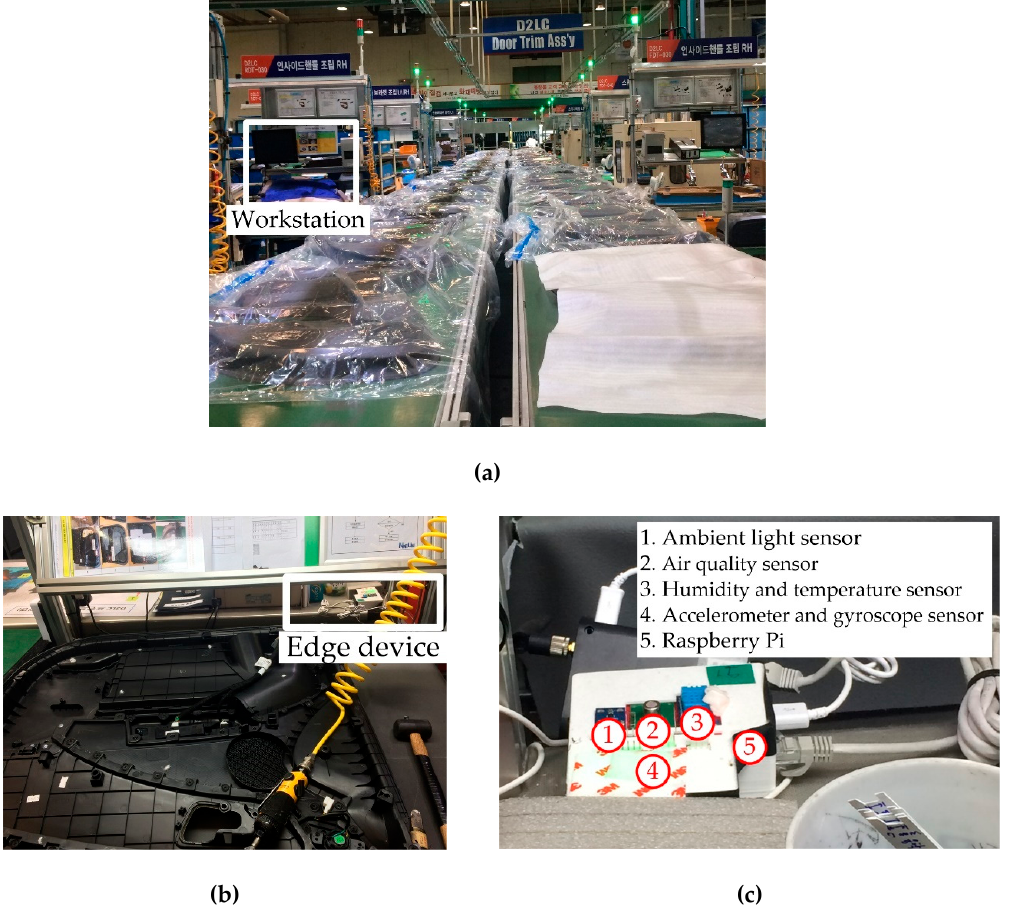
Figure 3. Proposed AFEWS implementation: (a) door trim assembly line, (b) workstation, (c) edge device.